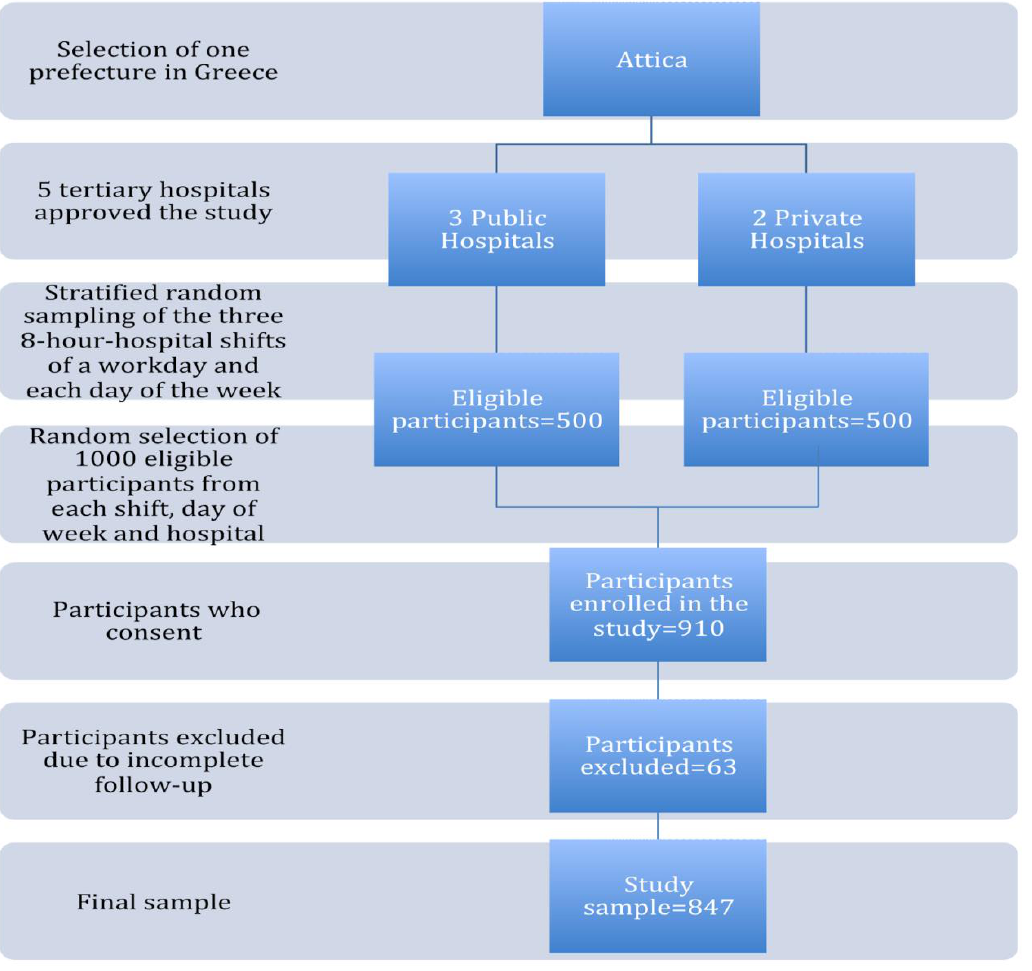
Figure 1. Flowchart of the multistage stratified random sampling method used in the study. (Attica/Greece 2020; n =847).